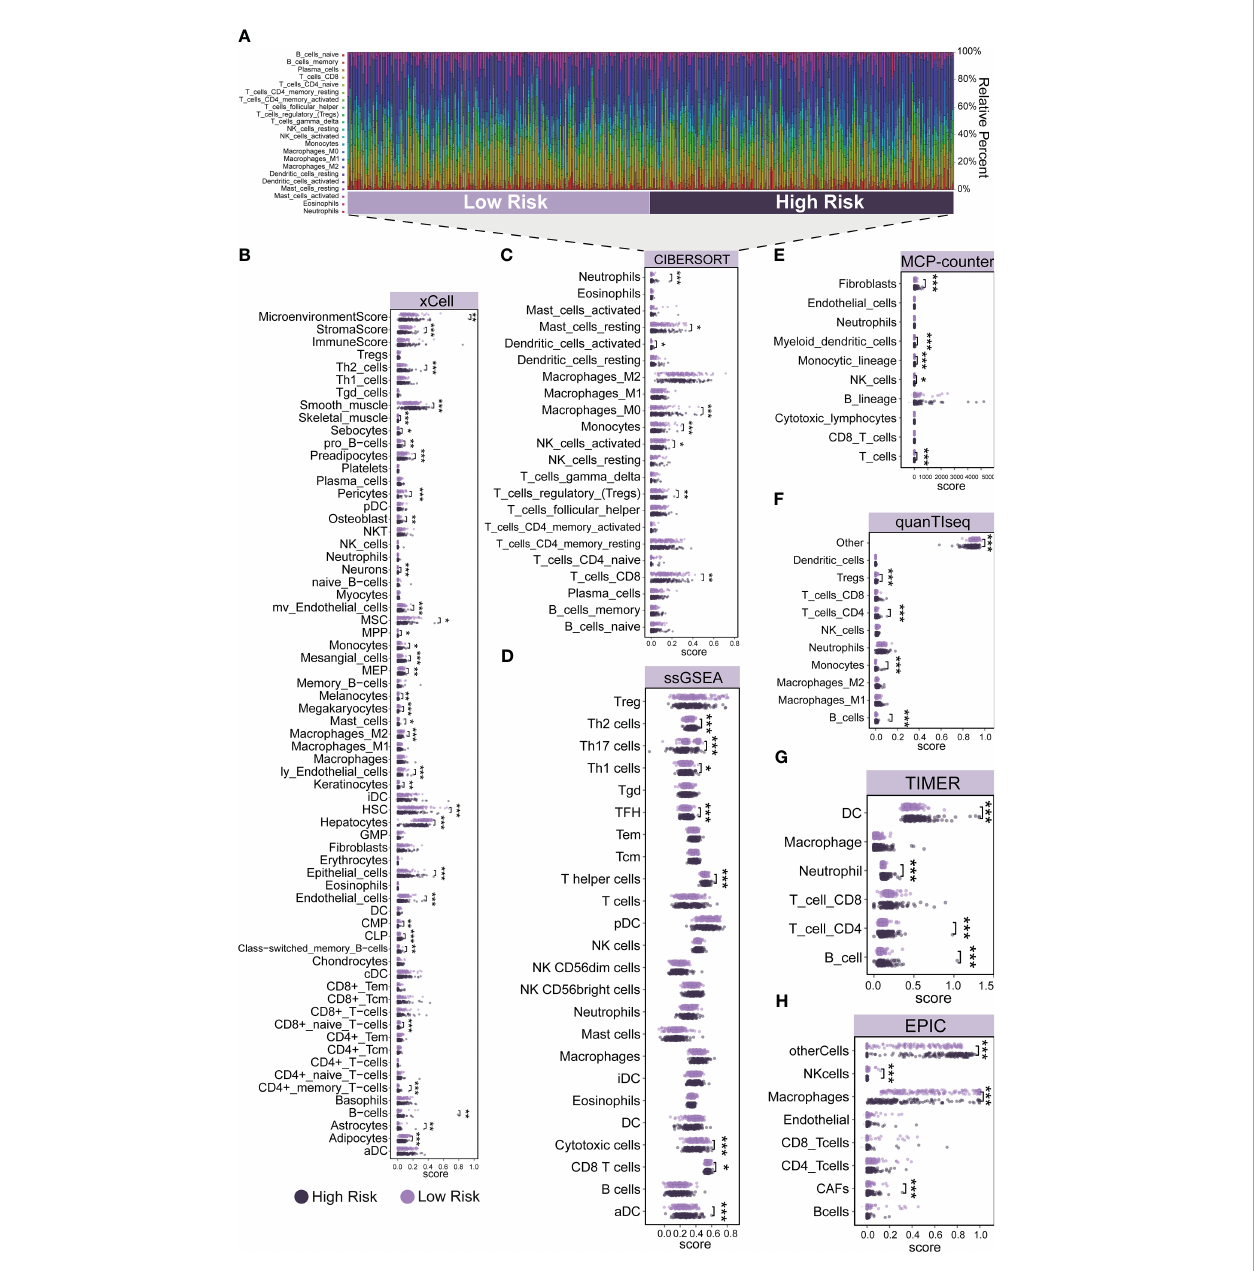
FIGURE 3 Immune cell in fi ltration patterns in different risk groups. (A) The relative percentage of 22 immune cells in the high-risk and low-risk groups. (B – H) Differences in immune cell in fi ltration between the high-risk and low-risk groups. (B) xCell, (C) CIBERSORT, (D) ssGSEA, (E) MCP-counter, (F) quanTIseq, (G) TIMER, and (H) EPIC. Signi fi cance signs: *p< 0.05; **p< 0.01; ***p<